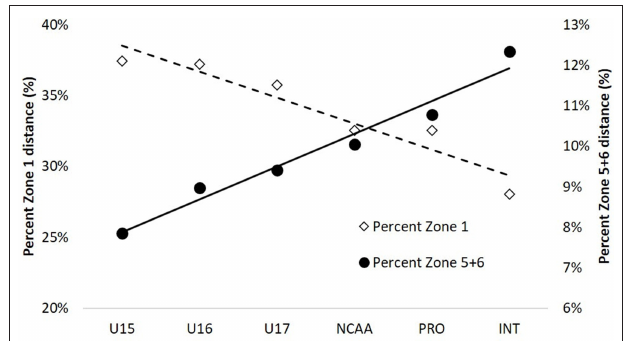
FIGURE 2 | Average percent distance of Zone 1 and Zone 5 + 6 across standards. Data from author